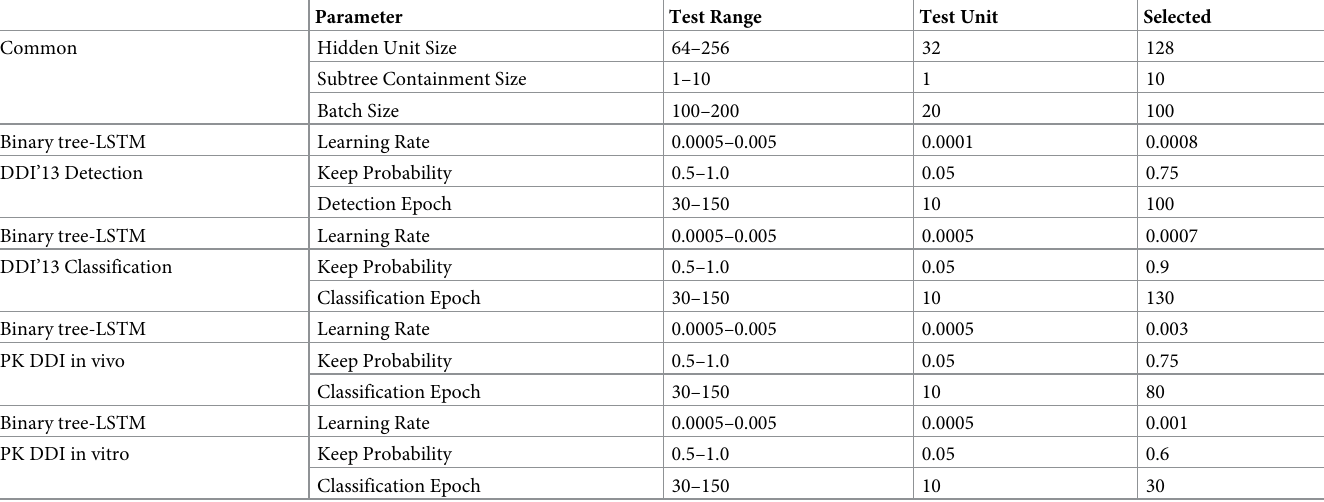
Table 3. Search process to find the best hyperparameters used for our